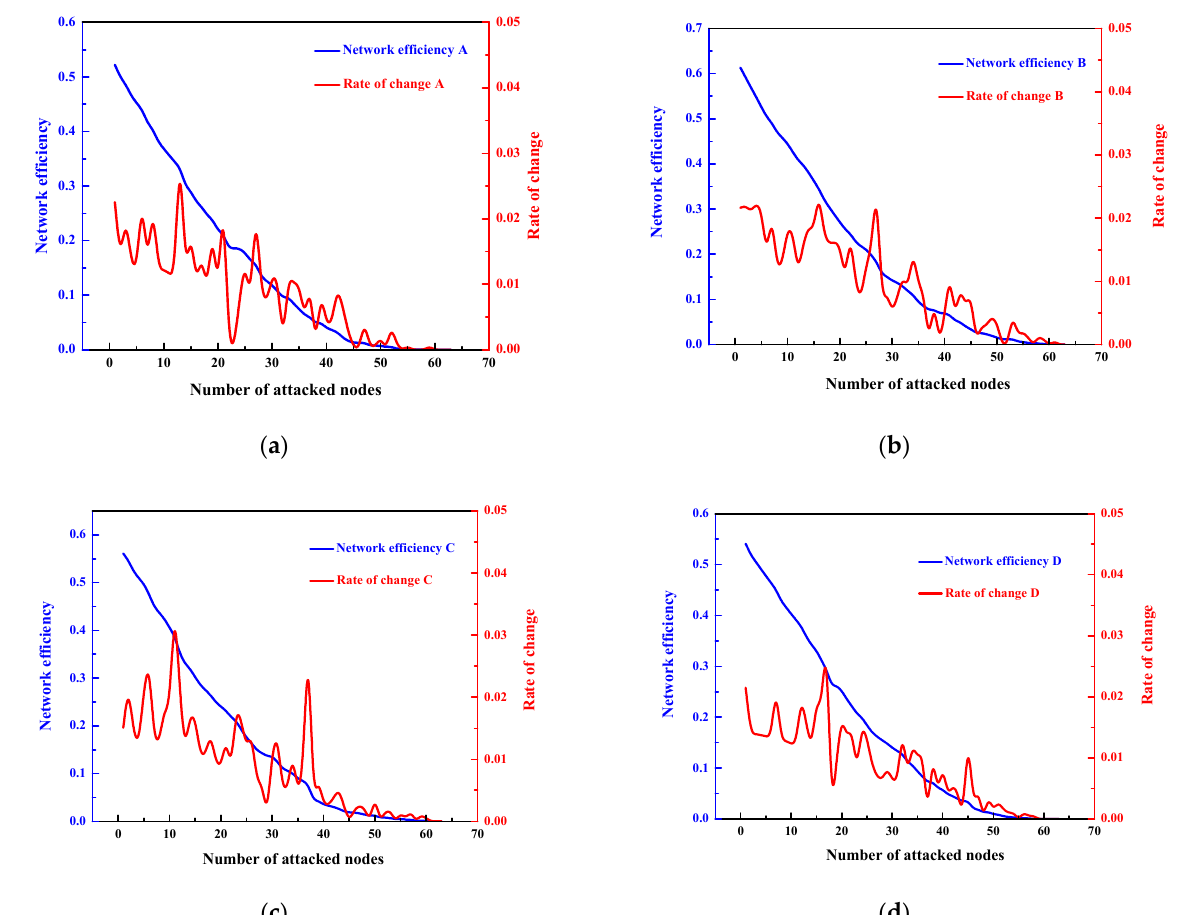
Figure 5. Graph of network efficiency and rate of change under random attack. ( a ) Network A; ( b ) Network B; ( c ) Network C; ( d ) Network D.